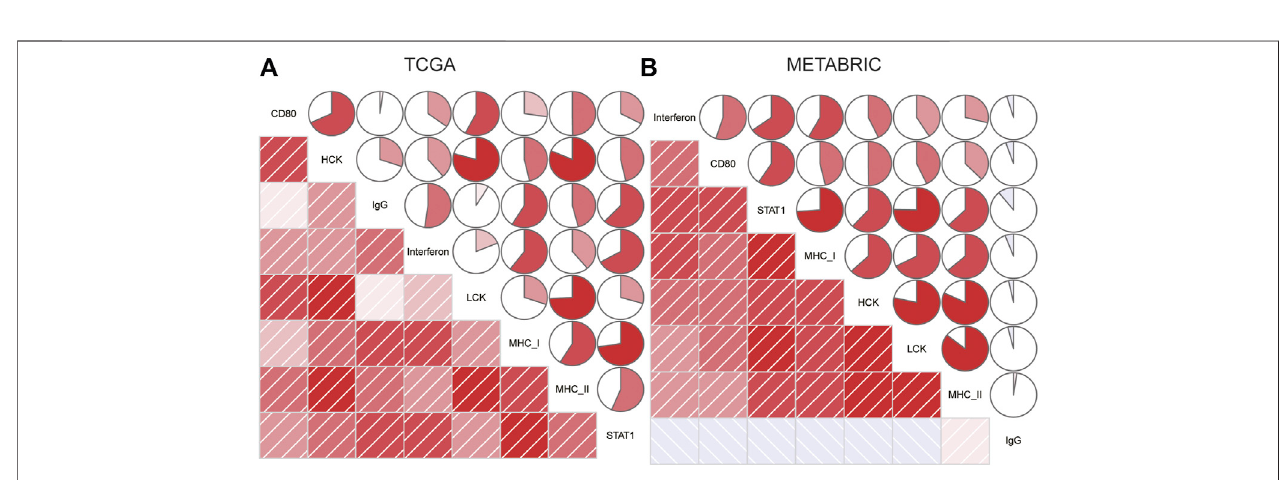
FIGURE 6 | Relationship between the CD80 expression and in fl ammatory activities in the TCGA and METABRIC cohort (A,B) .